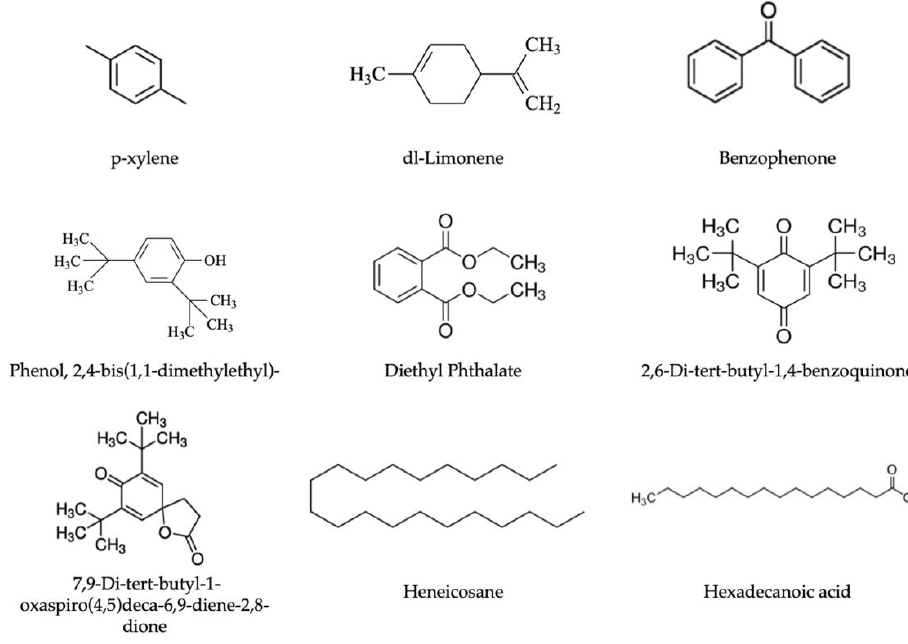
Figure 1. Structures of common compounds identified in PET samples. Table 2. GC-MS peak relative areas a of compounds identified in PET bottle samples.